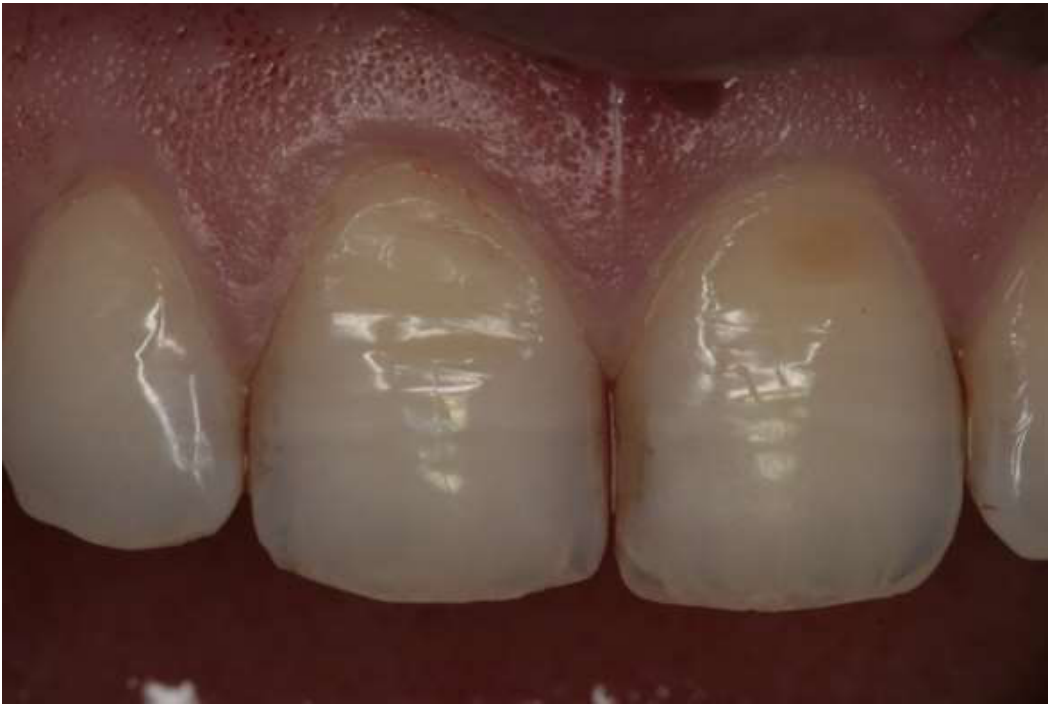
Figure 1. Erosive lesions on labial surfaces of central incisors (personal collection).